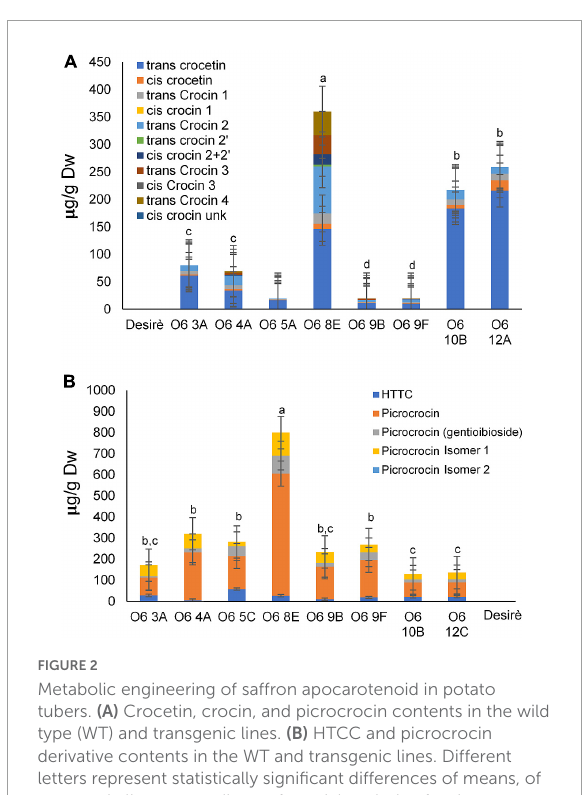
FIGURE2 Metabolic engineering of saffron apocarotenoid in potato tubers. (A) Crocetin, crocin, and picrocrocin contents in the wild type (WT) and transgenic lines. (B) HTCC and picrocrocin derivative contents in the WT and transgenic lines. Different letters represent statistically significant differences of means, of transgenic lines, according to factorial analysis of variance (ANOVA) ( P ≤ 0.01) (Tukey test). Error bars represent SD.